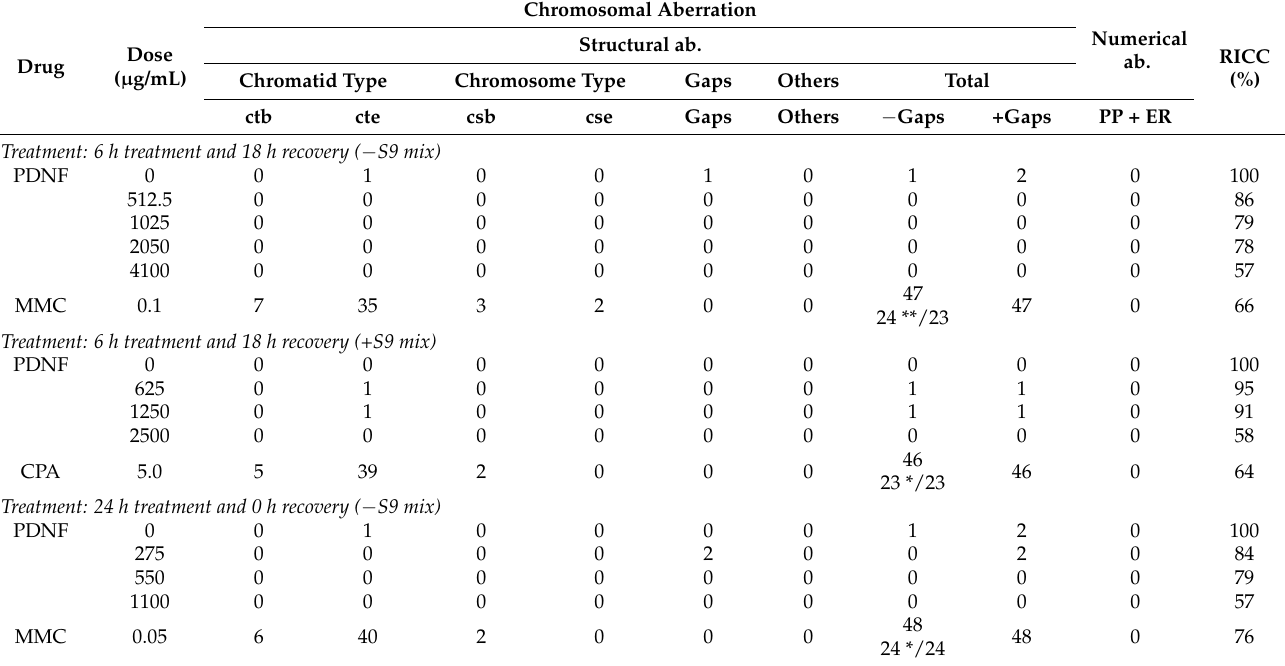
Table 4. Results of the chromosomal aberration test of powder of dried noni fruits